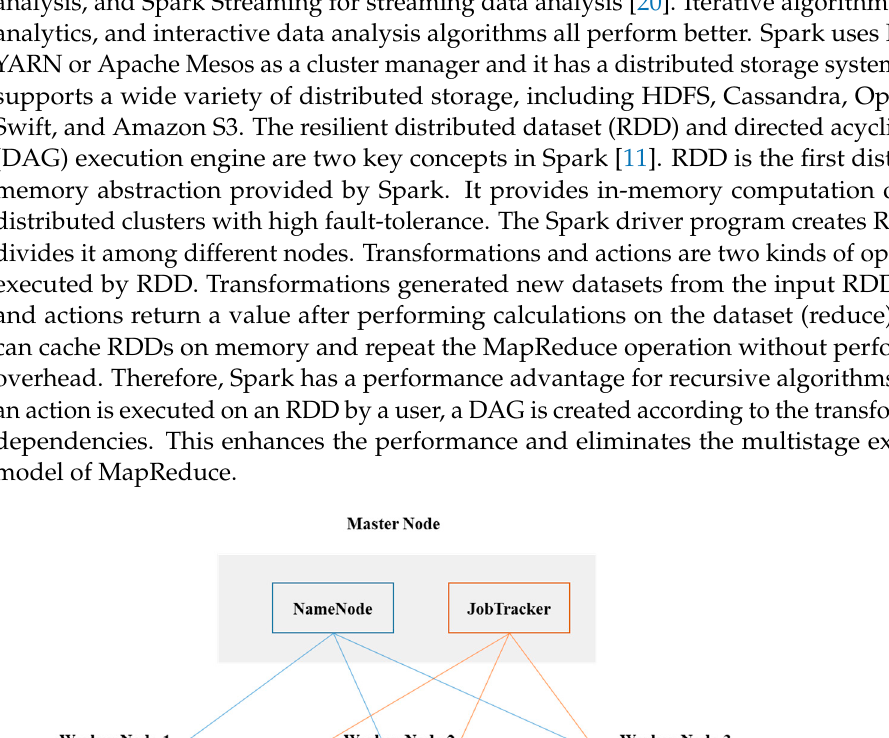
Figure 1. The MapReduce process in Hadoop.